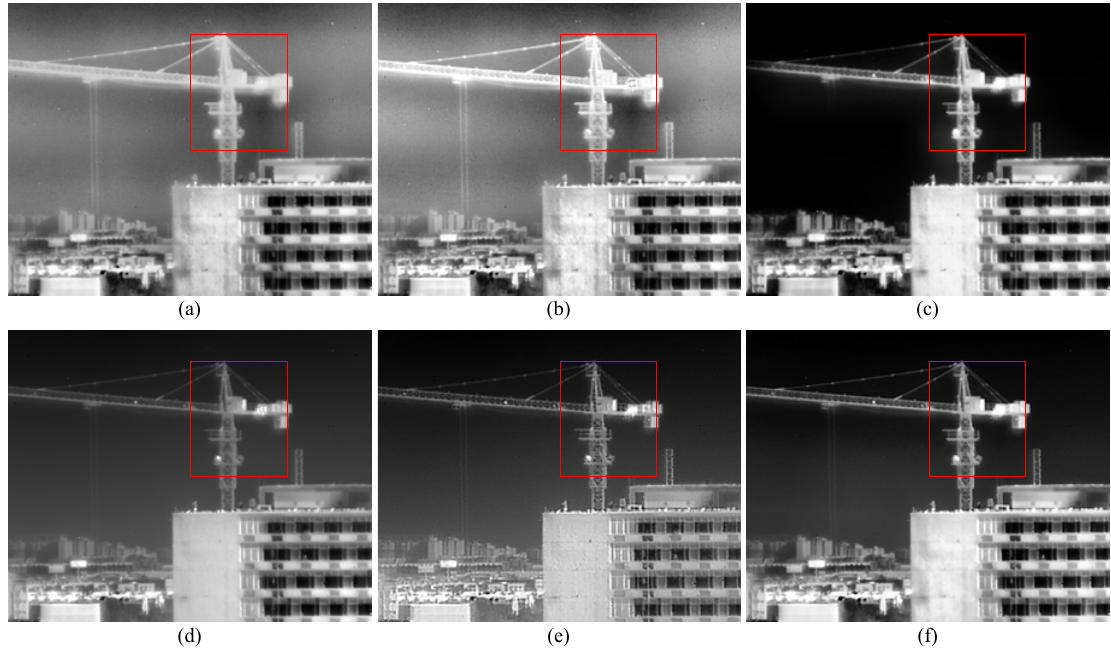
( f ) Proposed. GLHS,